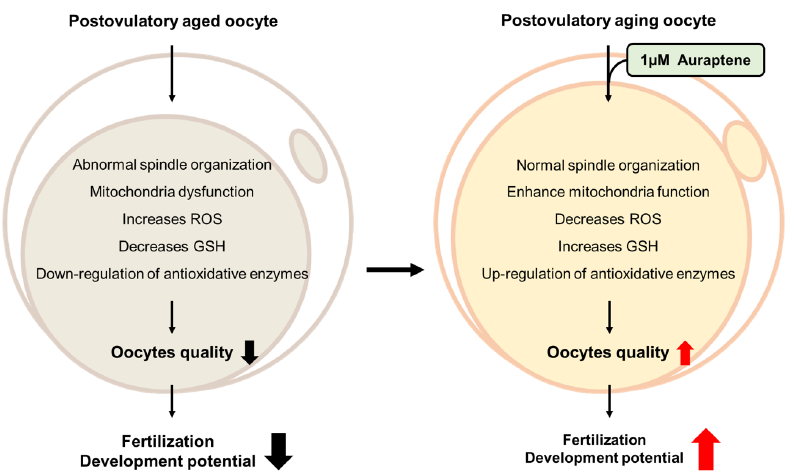
Figure 8. Auraptene can effectively delay postovulatory oocyte aging in vitro by alleviating oxida- tive stress. Briefly, we found that AUR inhibited not only spindle defects but also mitochondrial dysfunctions. In addition, the AUR treatment showed exhibit high GSH level and increase expression of antioxidant enzymes ( Nrf2 , Gclm , Gclc , Gpx1 and Sod1 ) while decreasing the ROS level. Moreover, AUR can improve fertilization and preimplantation embryo development. Thus, we conclude that AUR may be able to provide as a potent antioxidant in